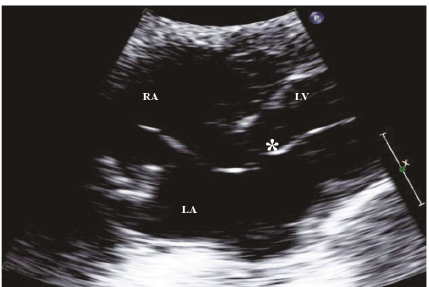
Figure 3: Transthoracic echocardiography, subcostal view showing the ventricular pacing lead ( ∗ ) to pass from the right atrium via interatrial septal defect to the left atrium and then via the mitral valve to the left ventricle. RA: right atrium; LA: left atrium; LV: left